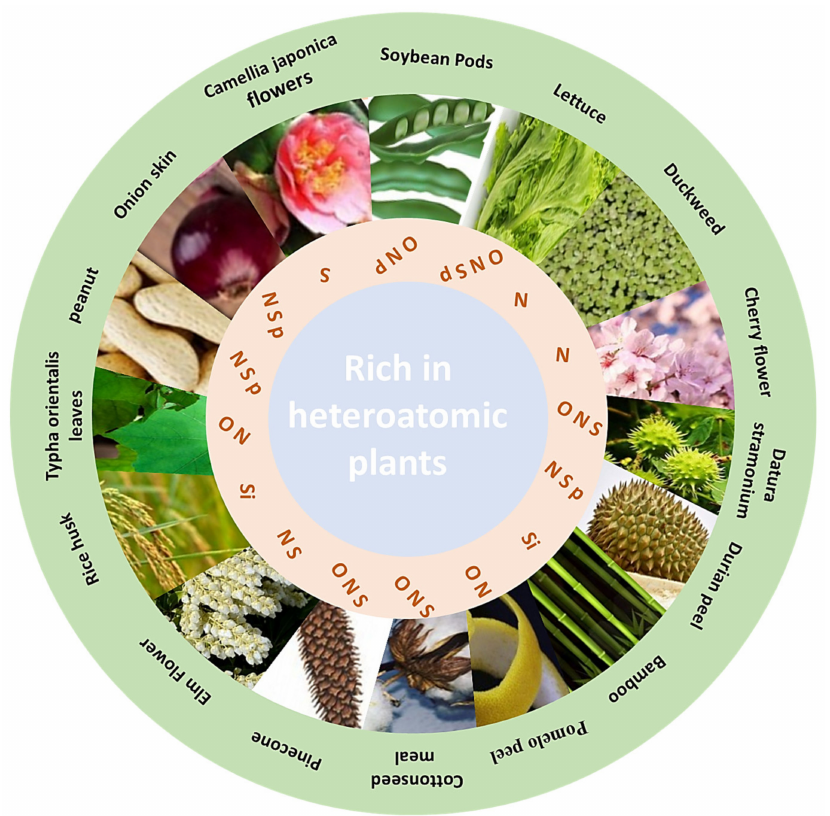
Figure 1. Plants rich in heteroatoms: Elm Flower [37], Datura stramonium seed pods [20], bamboo [38], Pinecone [39], Durian peel [40], Rice husk [41], Peanut meal [42], Typha orientalis leaves [43], Lettuce slice [44], Soybean pods [45], Onion skin [14], Camellia japonica flowers [35], Duckweed [36], Hollyhock leaves [46], Cottonseed meal [47], Pomelo peel [48], Cherry flowers